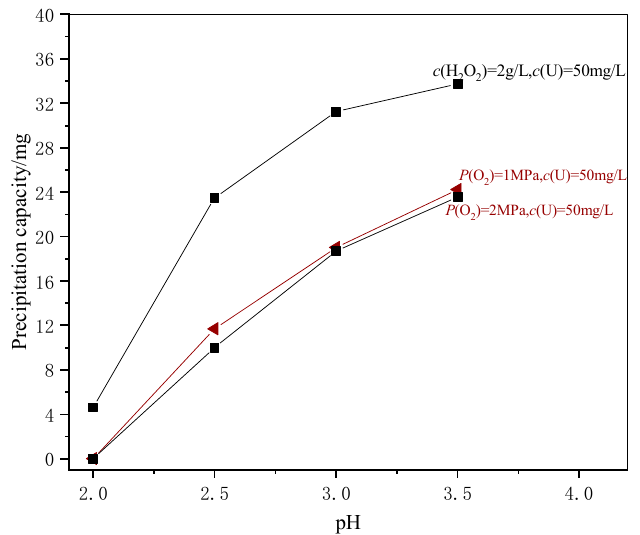
Figure 12. Precipitation amount of Fe(II) under different oxygen pressures ( c (Fe(II)) =2.0 g/L).